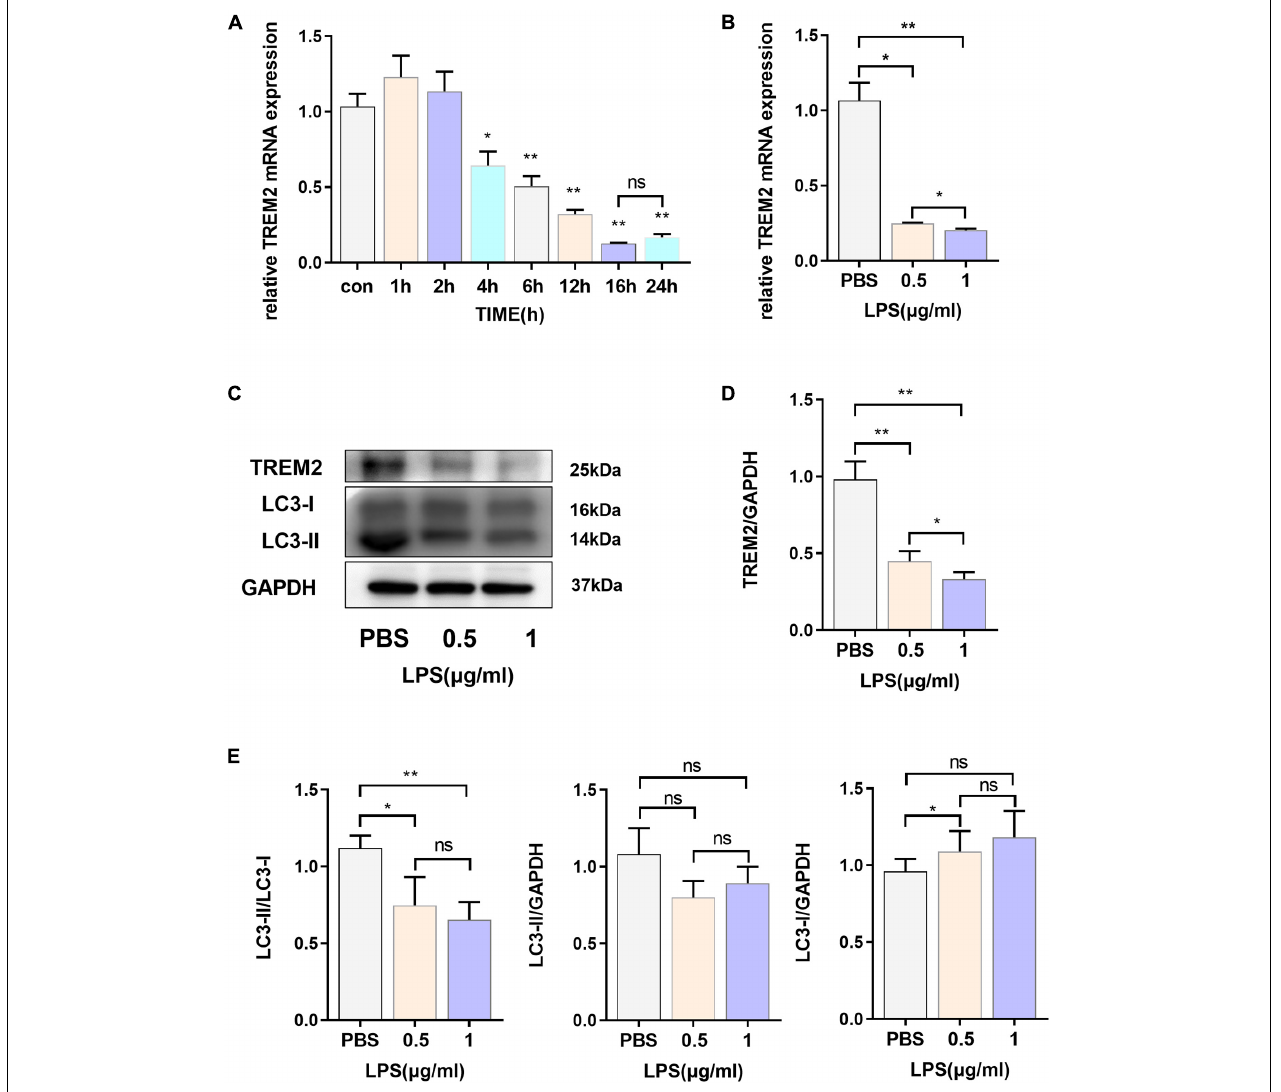
FIGURE 1 | The express ion levels of TREM2 are down-regulated in LPS-induced BV2 cells. (A) After BV2 cells were incubated with 1 µ g/ml LPS for different times (0, 1, 2, 4, 6, 12, 16, and 24 h), the mRNA expression level of TREM2 was detected by RT-qPCR ( n = 3/group) ( F = 77.91). (B) After BV2 cells were incubated with 0.5 or 1 µ g/ml LPS for 24 h, the mRNA expression level of TREM2 was detected by RT-qPCR ( n = 3/group) ( F = 148.3). (C) After cells were treated with different concentrations of LPS (0.5 or 1 µ g/ml) for 24 h, the expression of TREM2 and LC3 were detected by WB ( n = 3/group). (D) The expression level of TREM2 was analyzed by quantitative analysis of protein ( F = 53.4). (E) The expression level of LC3II and LC3I was analyzed by quantitative analysis of protein, and the ratio of LC3II/LC3I was shown ( F = 15.93). All the quantitative analysis of protein was done by Image J to calculate the gray value. Data are shown as the mean ± SE. The fold change is significant where * P < 0.05, ** P < 0.01. n = number of independent cell culture